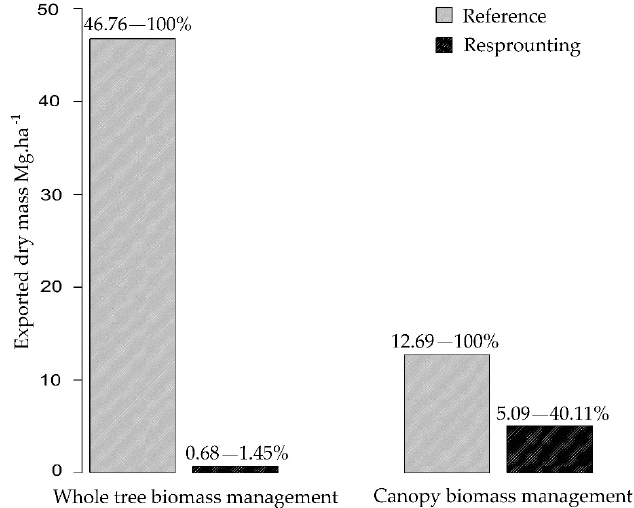
Figure 5. Dry mass exported by the sequential management of rosewood plantations via whole tree removal and 100% canopy pruning of trees located in the Central Amazon. Percentage values represent the percentage of above ground dry weight by the resprouting process.